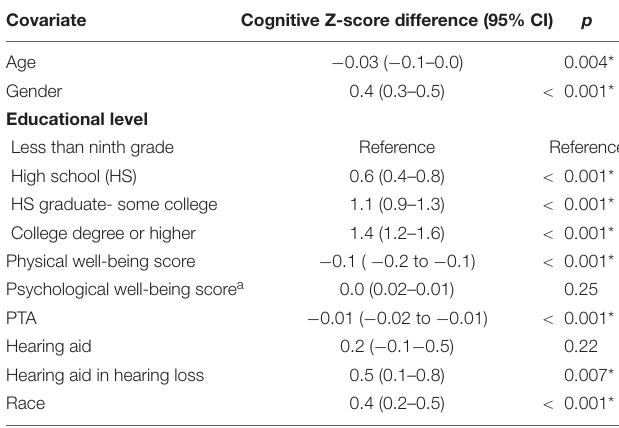
TABLE 1 | Covariate’s association with cognition using univariable linear